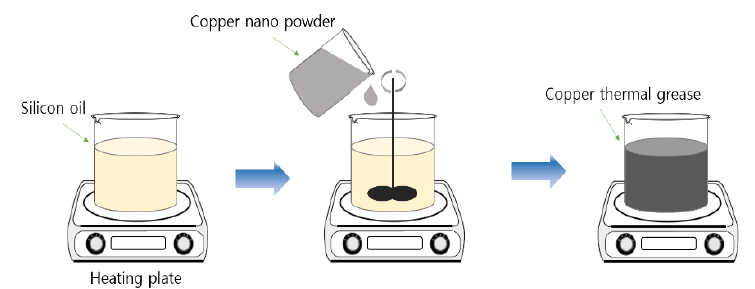
Figure 3. Manufacturing process of nano thermal grease.